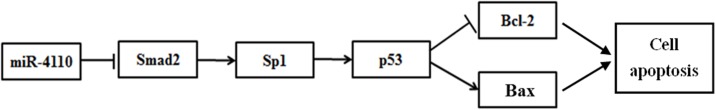
Proposed model of chi-miR-4110 regulation in caprine GCs.Chi-miR-4110 represses Smad2, increasing Sp1 expression; the increaseinSp1 induces p53-upregulated modulator of apoptosis (PUMA), which increases the relative abundance of Bax and causes caprine GC apoptosis.